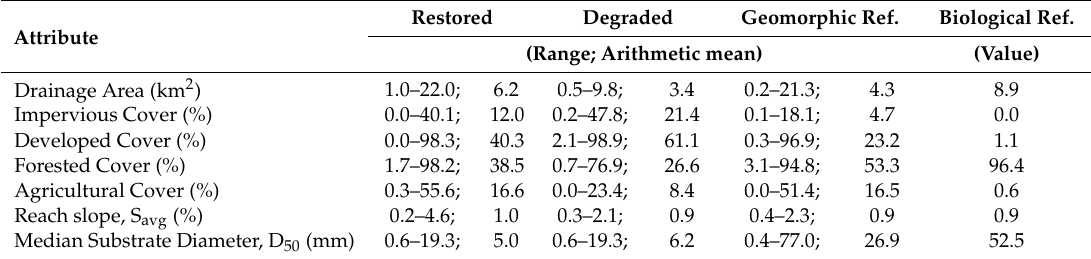
Table 1. Select attributes for restored (n = 9), degraded (n = 6), geomorphic reference (n = 18) study sites and the biological reference (n = 1) study site located in the Piedmont ecoregion, NC (Southeast, USA).